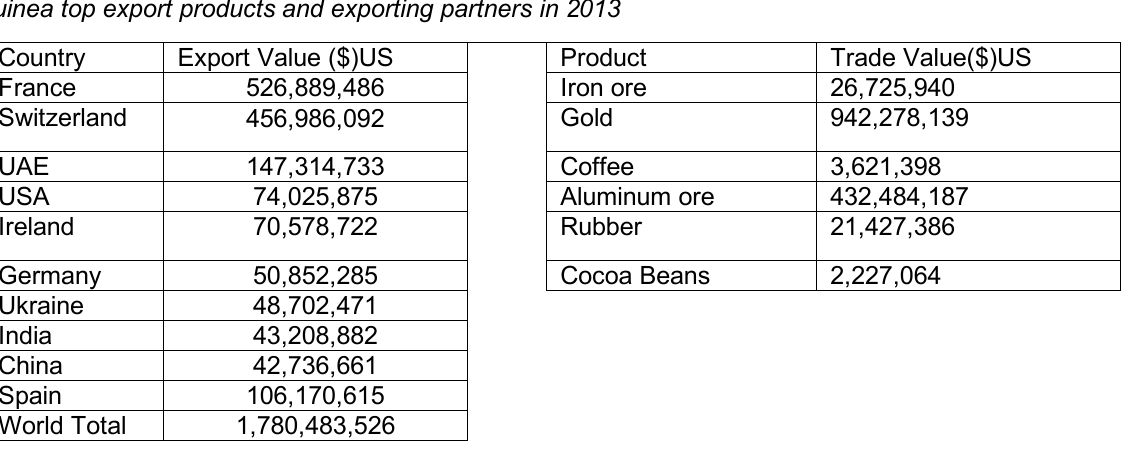
Table 1b: Export trading partners and products of Liberia (MoCI, 2013 Annual Bulletin) Liberia top export products and exporting partners in 2013